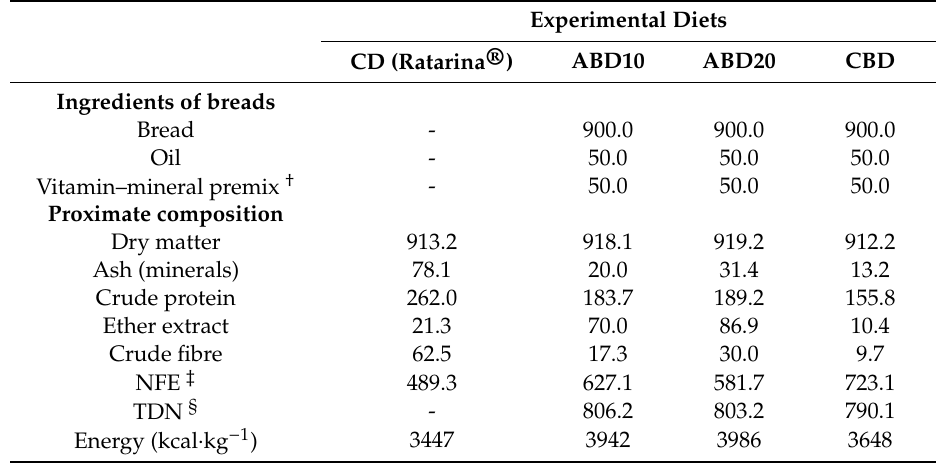
Table 1. Ingredients and proximate composition of breads made with amaranth flour, commercial bread and control diet (as feed, g · kg − 1